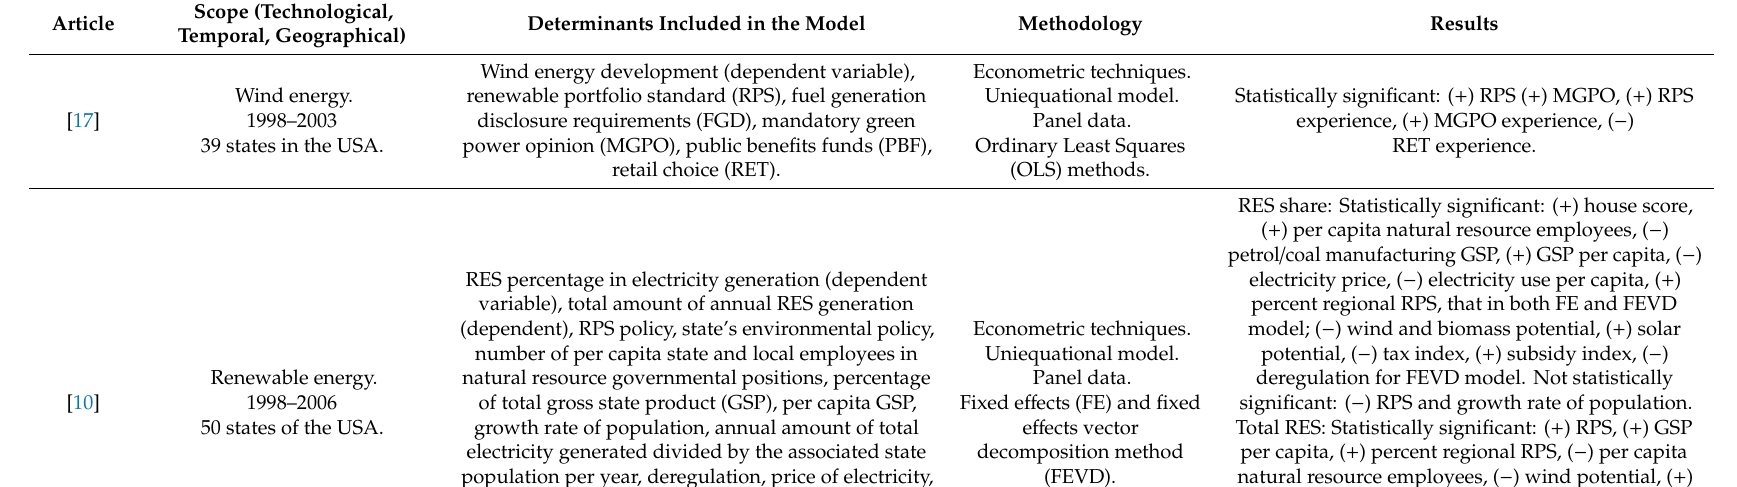
Table 1. Econometric studies on the determinants of